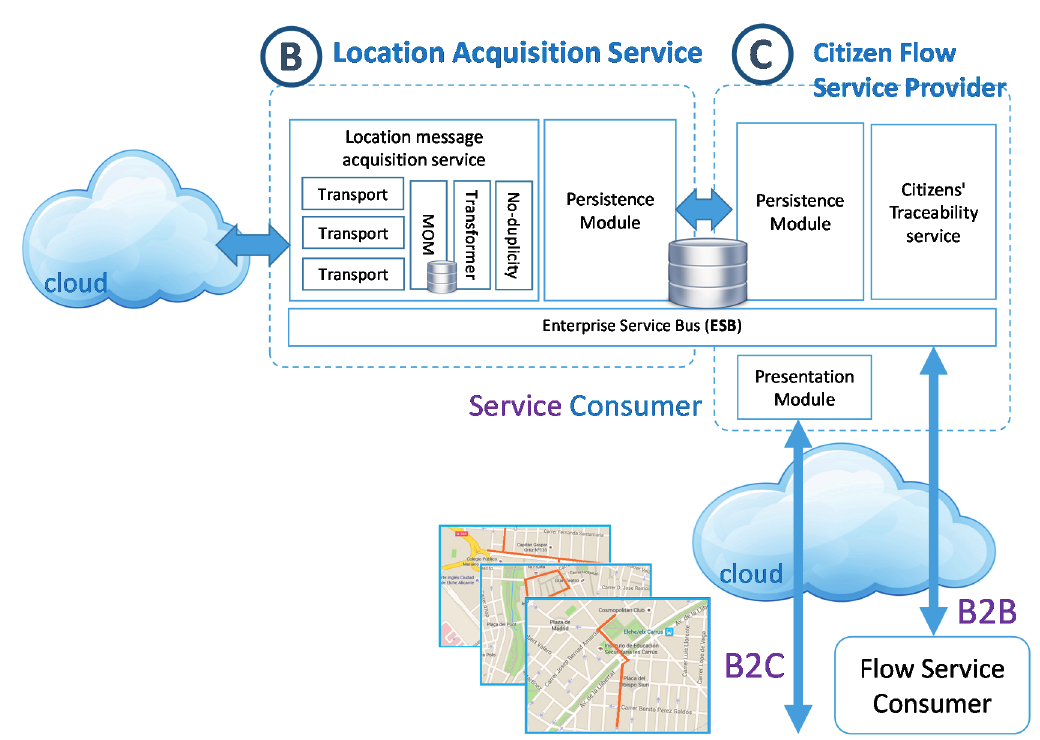
Figure 10. Location acquisition service